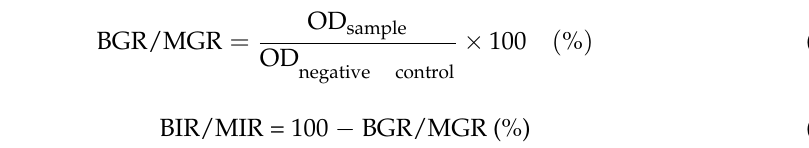
Figure 3. Antimicrobial activity of extracts expressed as BIR/MIR (%) calculated according to Formula (1). ( A ). CV extract; ( B ). RP extract; ( C ). MO extract; ( D ). OS extract.